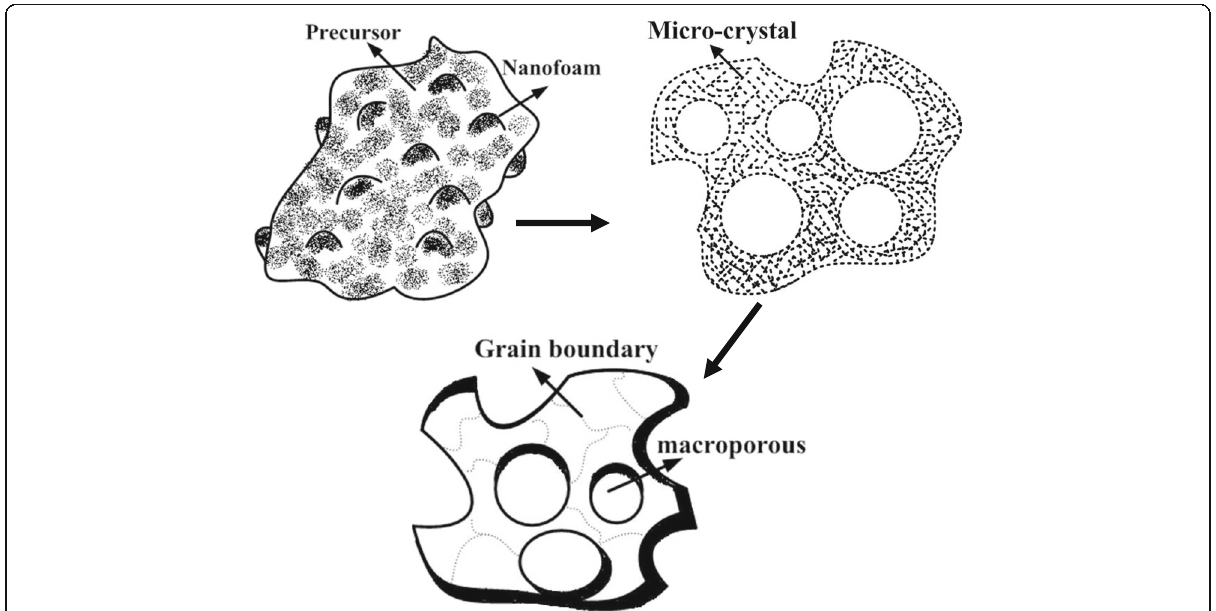
Fig. 6 The schematic mechanism for the growth of La 3 Ga 5.5 Nb 0.5 O 14 macroporous via a sol-gel route in our specially designed precursor solution